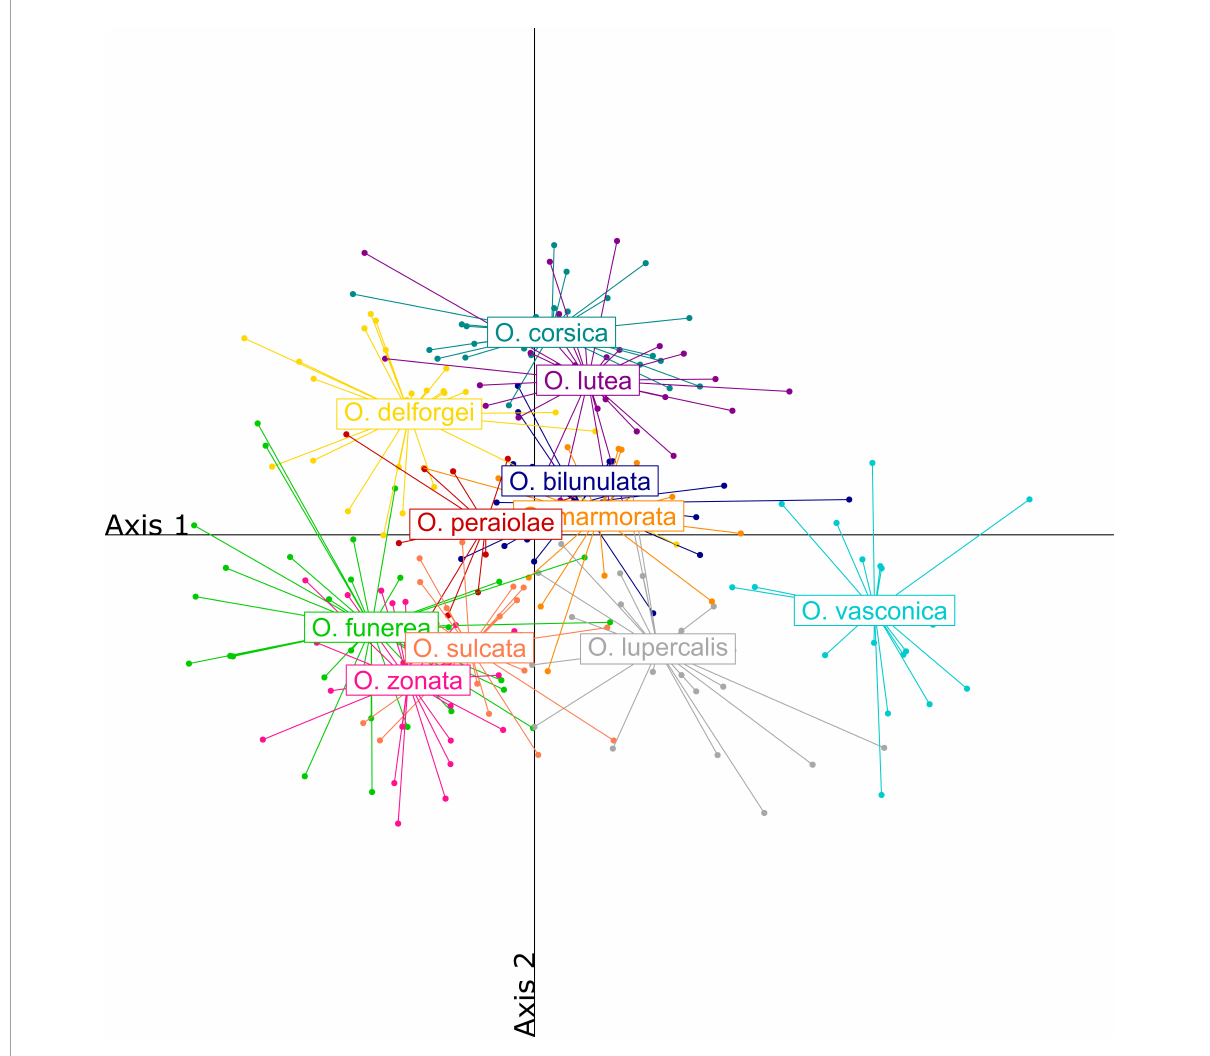
FIGURE3 Partial least squares-discriminant analysis (PLS-DA) of morphometric characters measured on the twelve French Pseudophrys taxa.